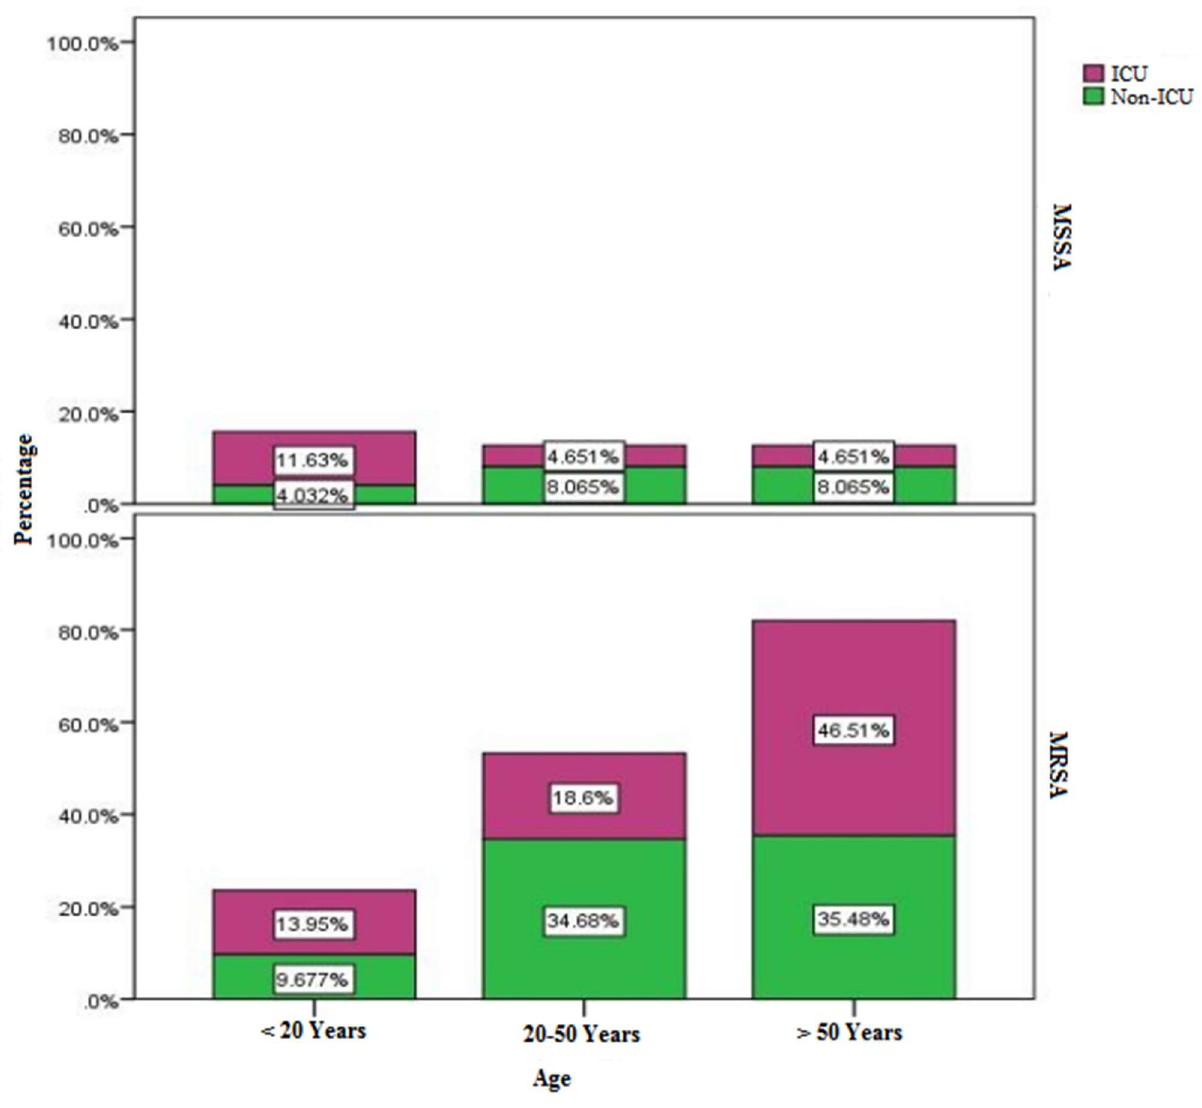
Figure 1. Age-group specific distributions of MRSA and MSSA isolates recovered from clinical specimens in ICUs, and other non-ICUs (inpatient and outpatient) settings in Ha’il hospitals, Saudi Arabia. Abbreviations: MRSA—Methicillin-resistant Staphylococcus aureus ; MSSA– Methicillin-sensitive Staphylococcus aureus ; ICU-intensive care unit; non-ICU-non-intensive care unit.